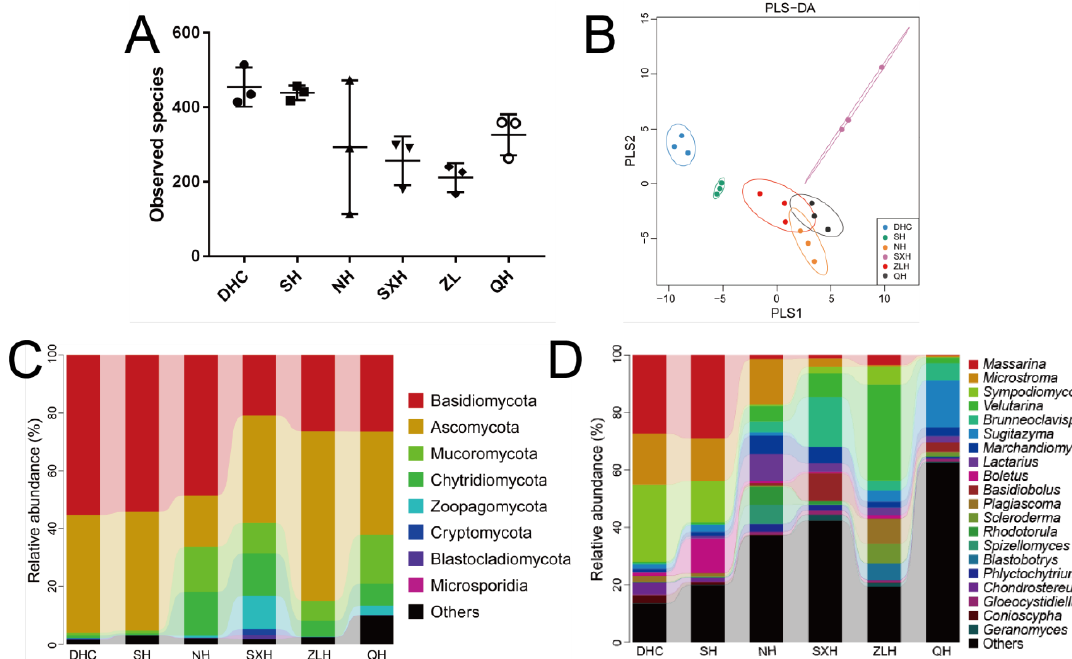
Figure 4. Fungal composition analysis using high-throughput sequencing. ( A ) Observed species of water samples of DHC, SH, NH, SXH ZLH and QH. ( B ) Partial least squares discriminant analysis (PLS-DA) presenting the sample distribution. Composition and relative abundance of the fungal communities in water samples of the six lakes in phylum ( C ) and genus ( D ) based on 18S ribosomal RNA.